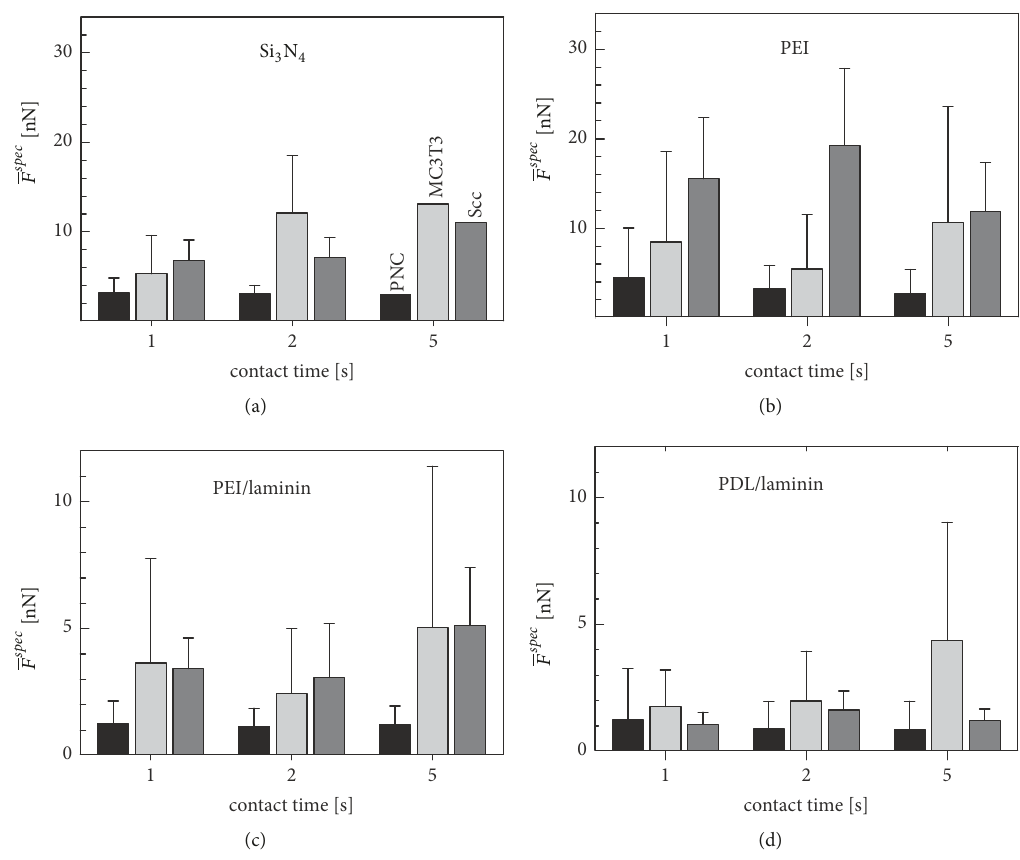
𝑠𝑝𝑒𝑐 Figure 4: Mean specific MDFs ( 𝐹 𝑠,𝑡 ) (see (4)) of PNCs (black), MC3T3 (light gray), and Scc (dark gray) on silicon nitride (a), PEI (b), PEI/laminin (c), and PDL/laminin (d) surfaces. The statistical differences in the characteristic MDF behavior of the cell types were analyzed by two-way variance analyses (Table 1).